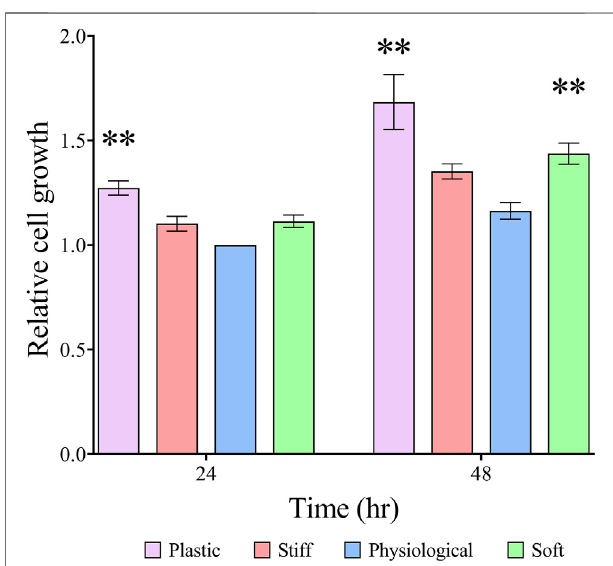
FIGURE 2 | TDC growth on substrates with different stiffness Cell growth was determined by alamarBlue ™ assay. Results are presented as means±SEM( n ≥ 4)normalized to24 hphysiologicalstiffnessgroup.Groups were compared by two-way ANOVA with post-hoc Dunnett ’ s test. ** p < 0.01, in comparison to cell growth on substrate with physiological stiffness of the respective